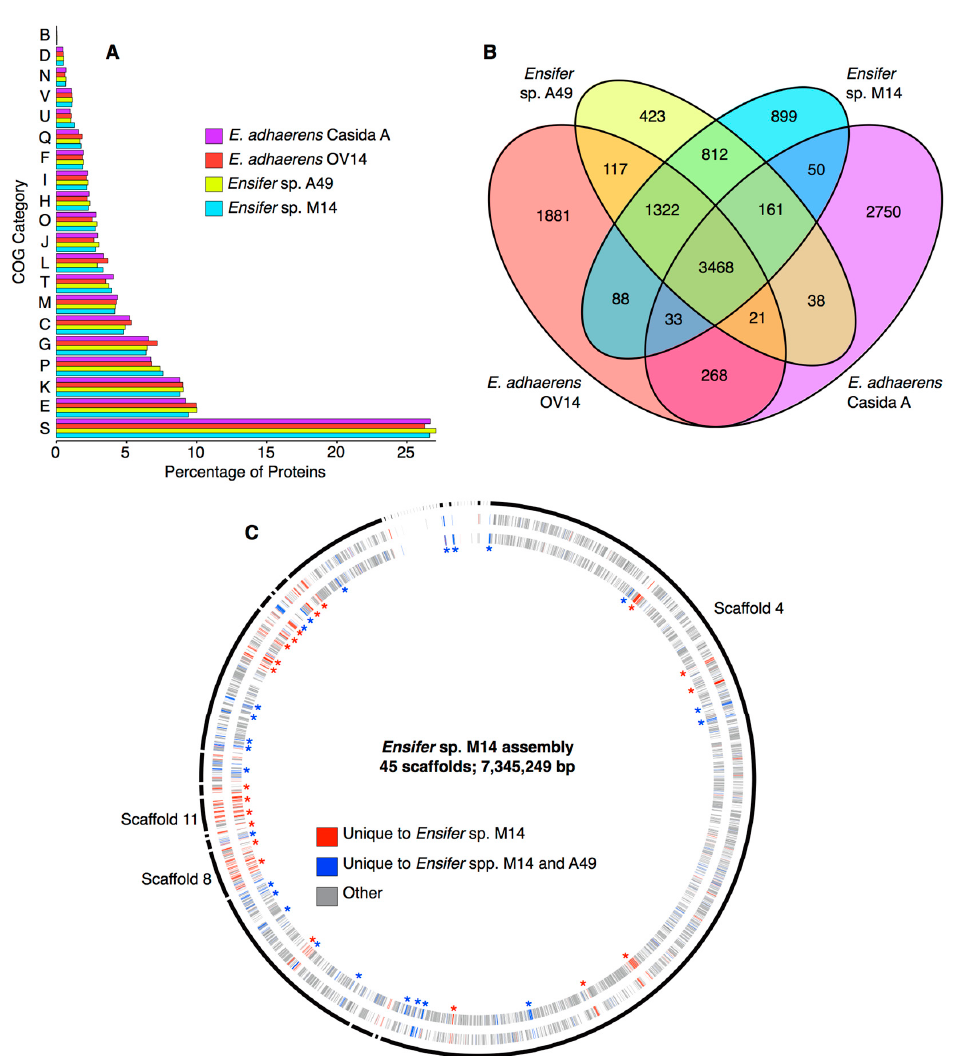
Figure 3. General features of the genome of Ensifer sp. M14 and related strains. ( A ) The percentage of proteins encoded by each strain annotated with each COG (Cluster of Orthologous Genes) functional category. COG categories not represented in the proteome are excluded from the graph. COG category definitions are provided in Table S4. ( B ) A Venn diagram indicating the number of genes shared among these four strains, as extracted from the pangenome of the 46 strains shown in Figure 2. ( C ) A circular plot, prepared with Circos version 0.67-7 [62], showing the scaffolds of the Ensifer sp. M14 assembly (outer black curved lines) including the plasmids, and the predicted coding sequences on the positive strand (outer ring) and negative strand (inner ring). Scaffolds are drawn proportional to their size, and they are presented in the order they are numbered. Scaffold 4 (chromosome), 8 (pSinB), and 11 (pSinA) are labelled. The coding regions are colored according to their conservation level, with red indicating genes unique to Ensifer sp. M14, and yellow indicating species common and unique to Ensifer spp. M14 and A49. Some multi-gene loci unique to M14 (red asterisks) or unique to M14 and A49 (blue asterisks) are